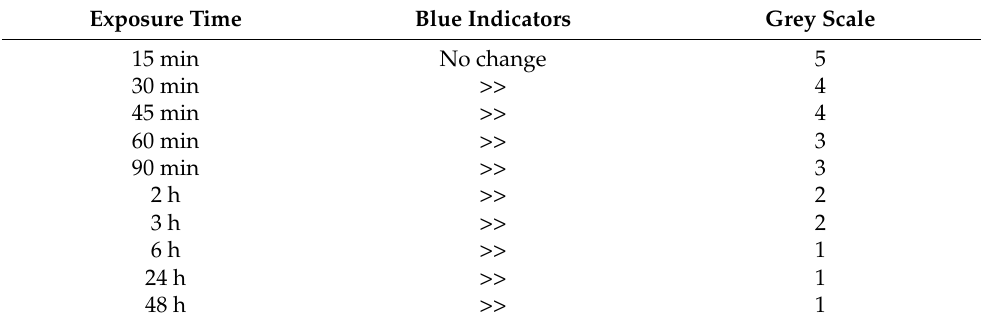
Figure 7. Visual observation, under D65 lamp, of aged specimens after 1 h ( a ) and after 3 h ( b ) in the ageing chamber. Table 3. Observations of visual comparisons by experimenter during UV